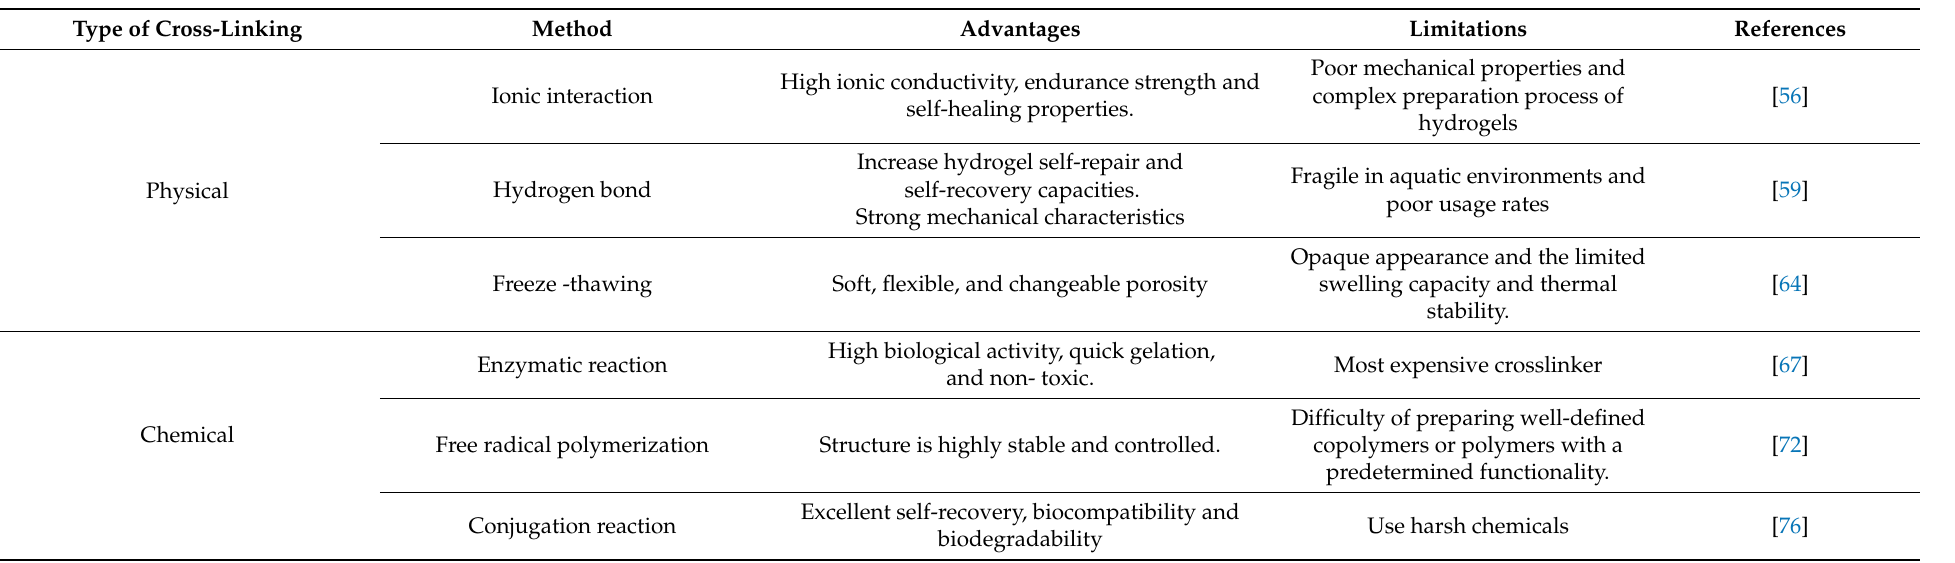
Table 2. Preparation method of hydrogel with its advantages and